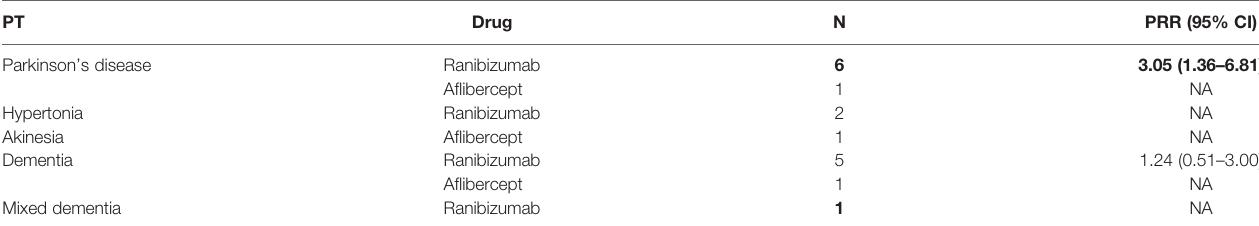
TABLE 4 | Individual case safety reports for intravitreal ranibizumab grouped by preferred term, in patients aged 65 years or older. PT N